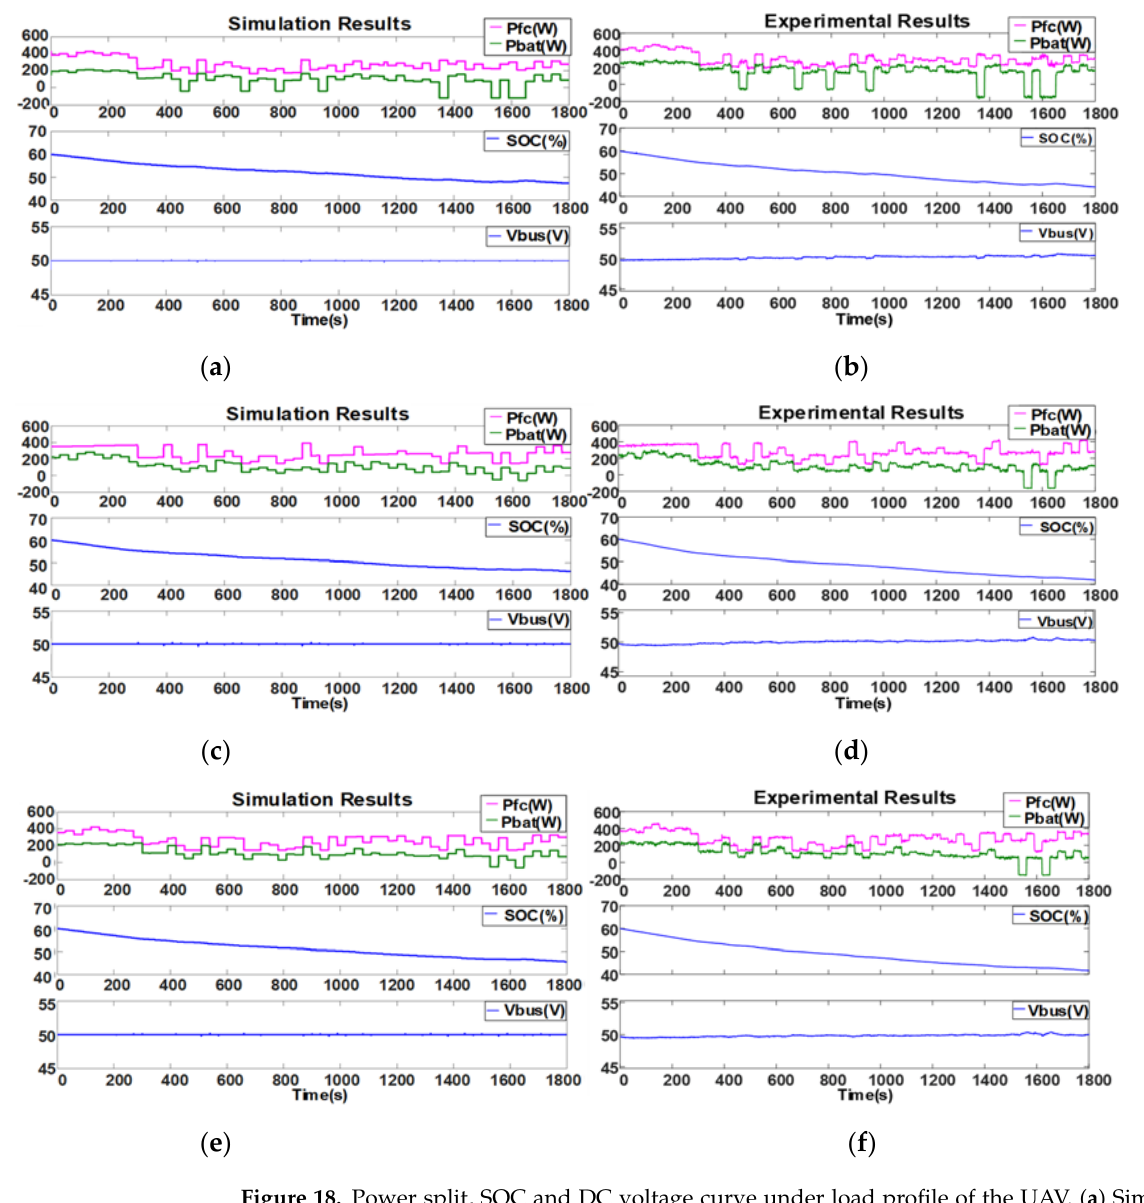
Figure 18. Power split, SOC and DC voltage curve under load profile of the UAV. ( a ) Simulation results for RB control; ( b ) experiment results for RB control; ( c ) simulation results for FL control; ( d ) experiment results for FL control; ( e ) simulation results for PSO ‐ FL control; ( f ) experiment results for PSO ‐ FL control. Table 4. Overall performance of three designed EMS.